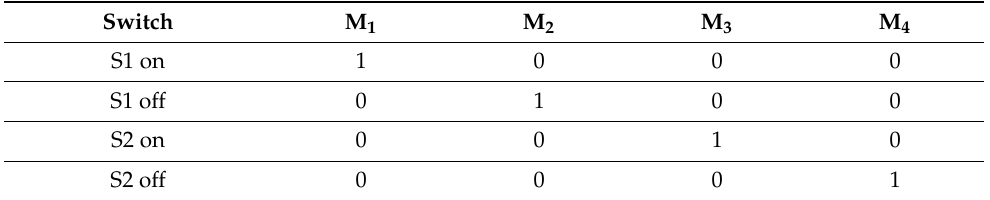
Table 1. Voltage sampling circuit drive